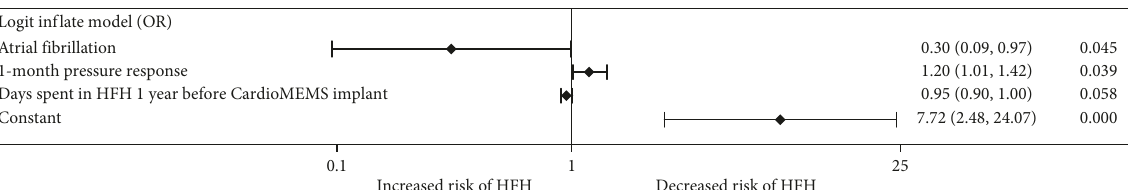
− PADP ). Of note, an odds D1 ⟶ D14 D15 ⟶ D28